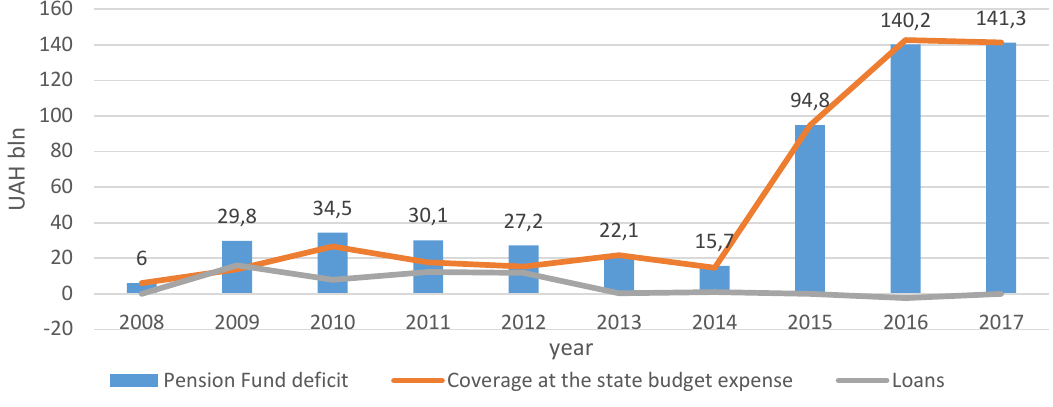
Figure 1. Dynamics of underlying deficit of the Pension Fund of Ukraine in 2008–2017, UAH bln